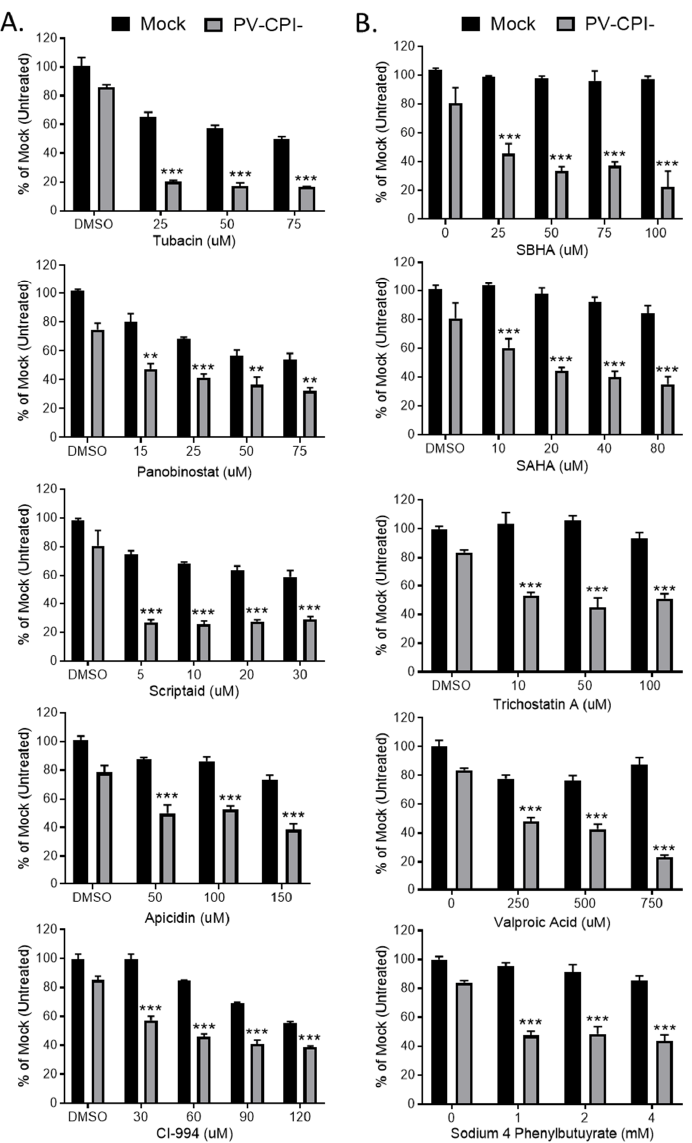
Figure 8. Di ff erential e ff ect of various HDAC inhibitors on killing of mock infected and P / V-CPI- infected human laryngeal cancer cells. ( A , B ) HEp-2 cells were mock infected or infected with P / V-CPI- at an MOI of 10 PFU / cell. At 12 hpi, cells were treated with indicated concentrations of HDAC inhibitors or solvent control. At 24 h post treatment, cell viability was determined by MTT assay. Graphs were organized based if HDAC inhibitors reduced viability of mock infected cells (panel A) or if the inhibitors did not reduce viability of mock infected cells (panel B). Values are the mean of three replicates with ** and *** indicating p -values of < 0.01 and < 0.001, respectively, comparing DMSO versus HDAC inhibitor treated infected samples. Error bars indicate standard